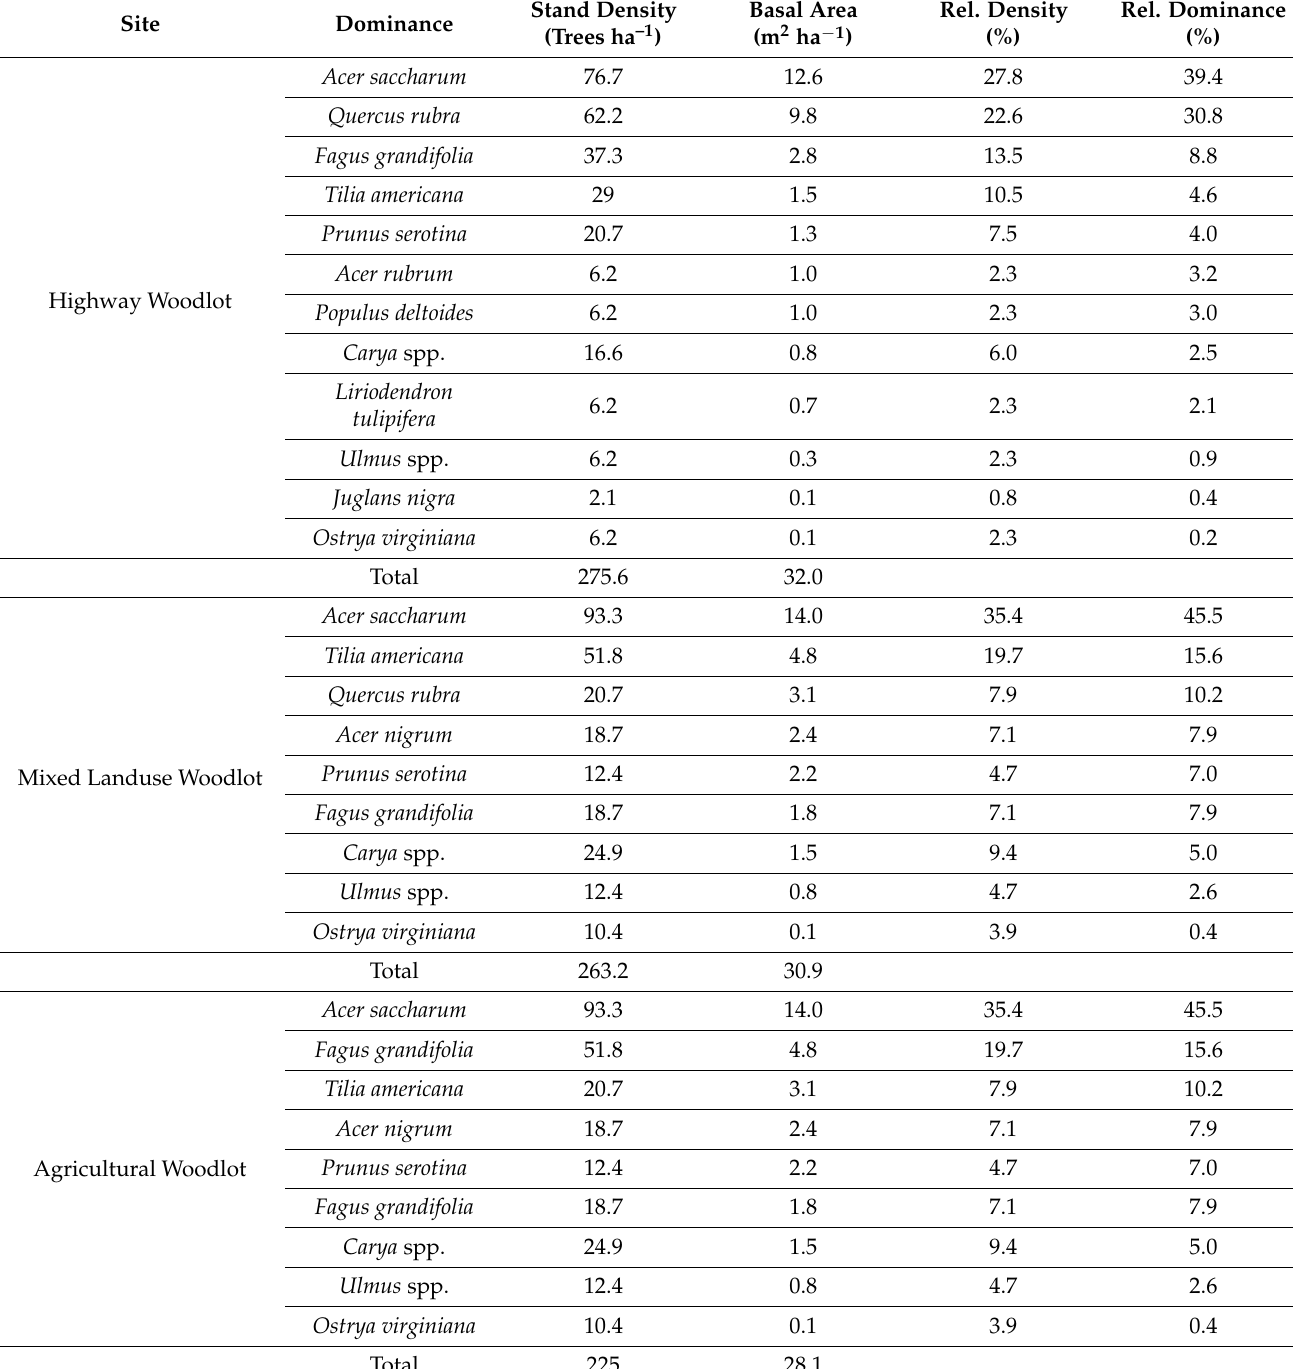
Table 1. Overstory species composition and structure of the three woodlots. Data are for all trees ≥ 10 cm dbh. Relative density is the percentage contribution of each species to total trees per hectare, whereas relative dominance is the percentage contribution of each species to the total stand basal